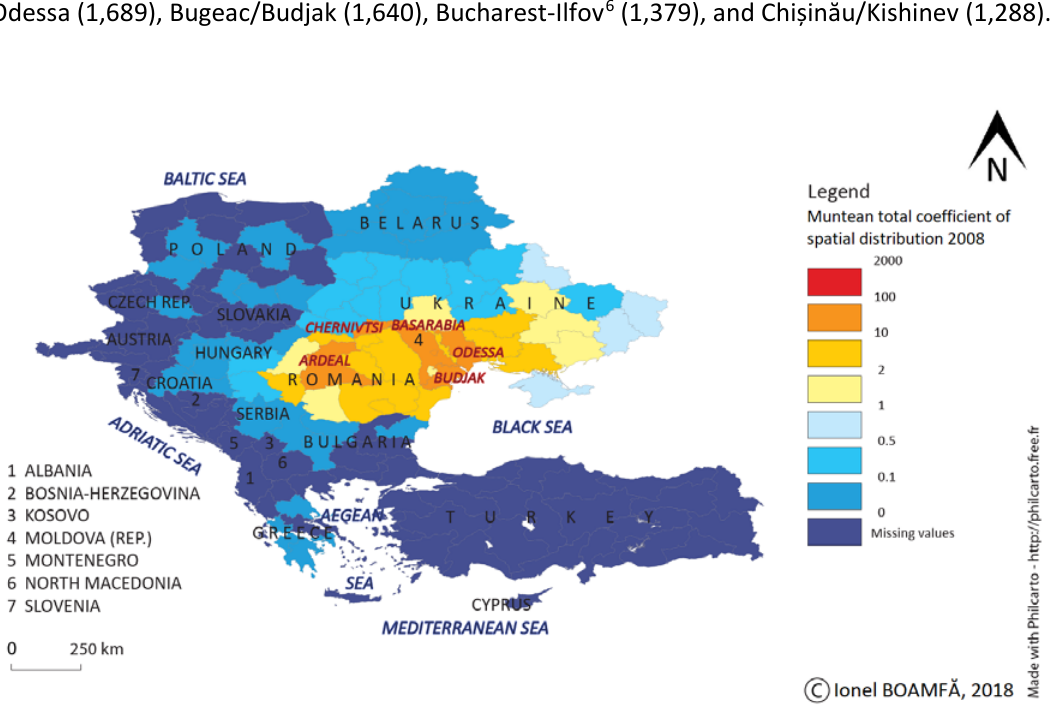
Figure 5. G eographical repartition of the anthroponym Muntean. Coef. of spatial